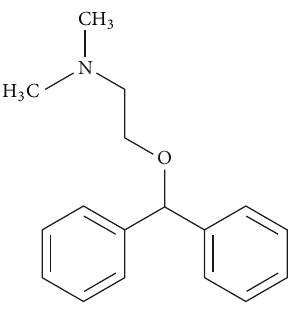
Figure 1: Structural formula of